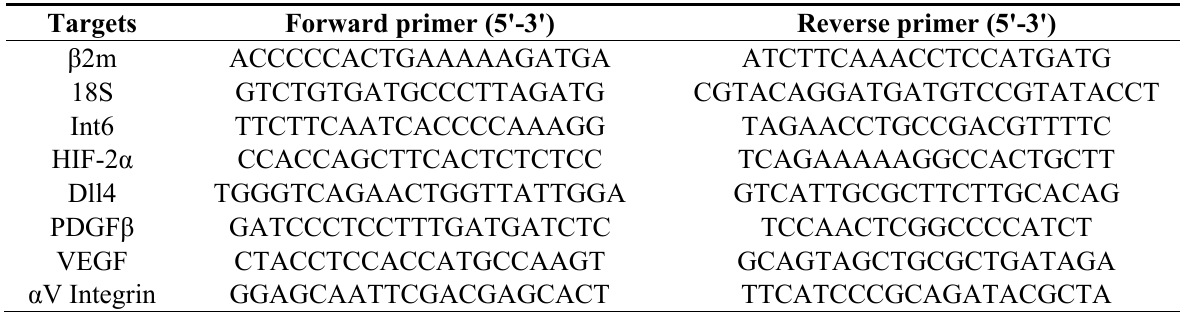
Table 2. qPCR primer